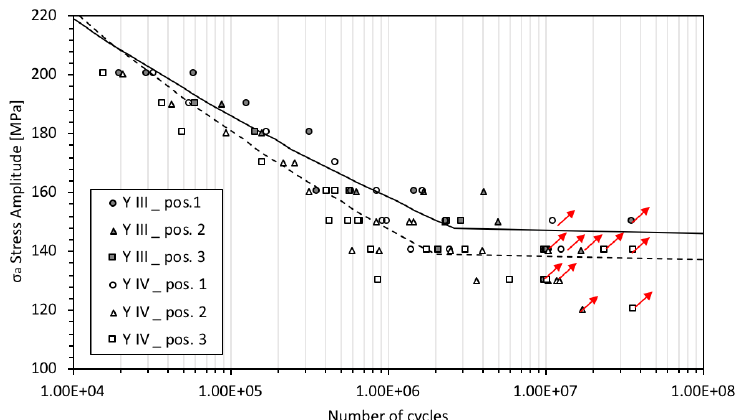
Figure 6. Fatigue life of specimens taken from different position within the cast samples. Solid line and dotted line represent the estimated fatigue curves at 50% survival probability for Y-shaped type III and type IV cast samples respectively. Run out specimens marked with an arrow.